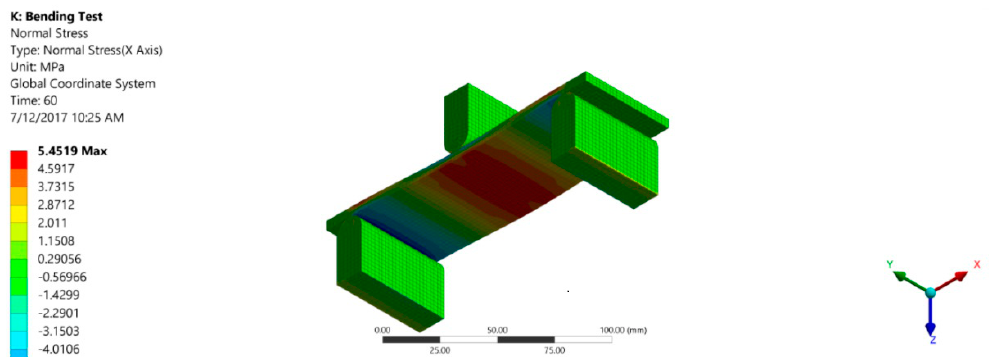
Figure 10. Image of simulation showing normal (flexural) stresses of sample in static bending test.